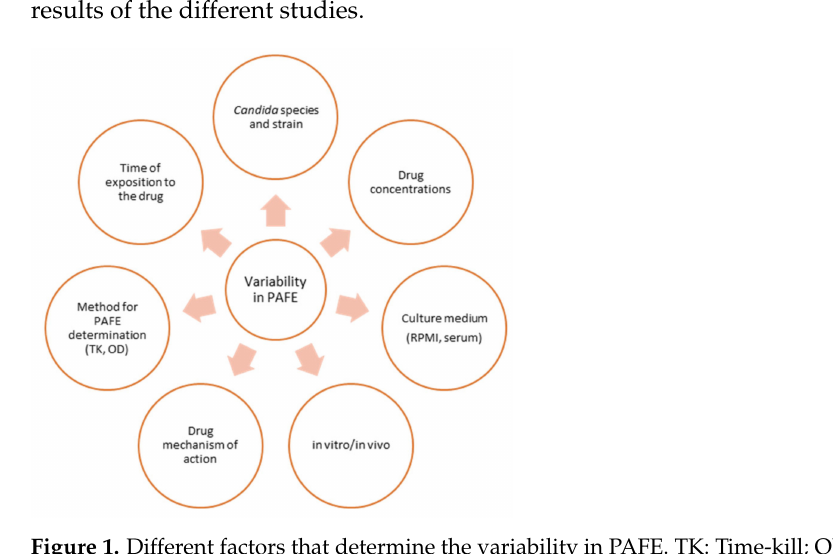
Figure 1. Different factors that determine the variability in PAFE. TK: Time-kill; OD: Optical